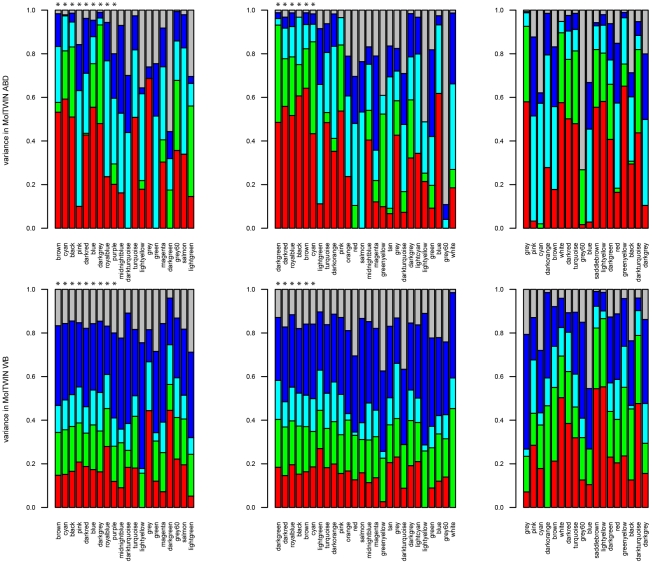
Sources of variation for module eigengenes.Median estimates from: A) MolTWIN ABD and B) MolTWIN WB. From left to right: eigengenes in MolTWIN are calculated from MolOBB ABD, GLU and WB probesets. In each plot, eigengenes are ordered by decreasing association with MetS from left to right (modules significantly associated with MetS are marked with * above the bar). Red is familiality, green is individual environment, cyan is individual visit, blue is common visit and grey displays residual variance.